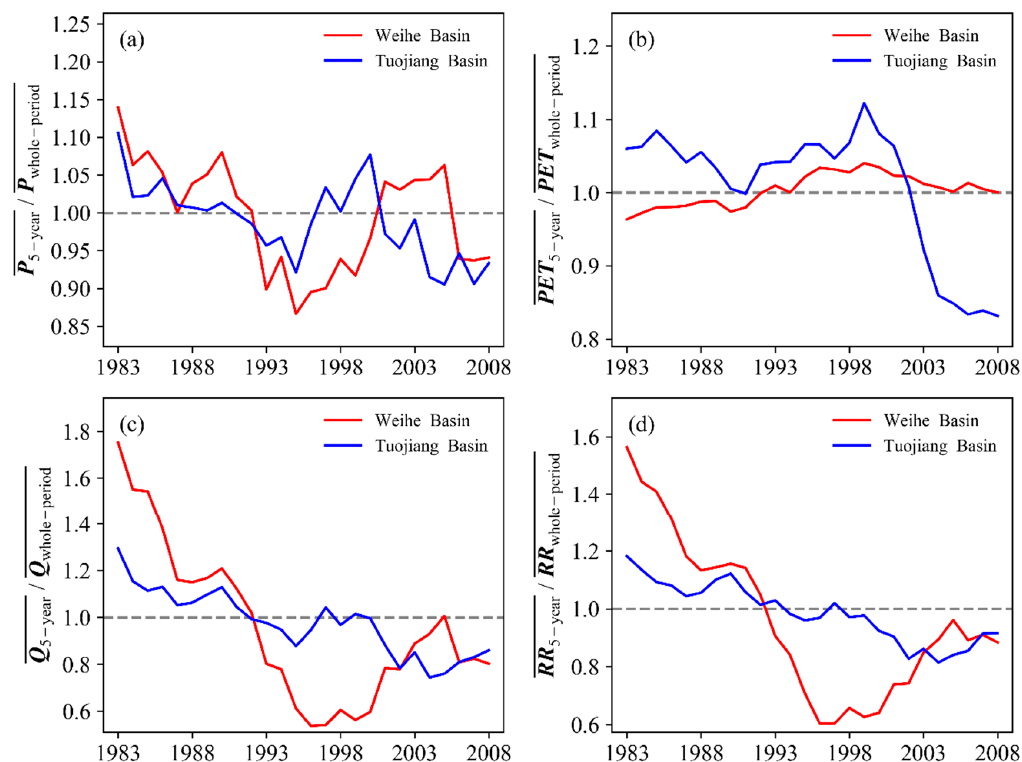
Figure 3. Relative long-term hydro-meteorological variability of ( a ) precipitation ( P ), ( b ) potential evapotranspiration ( PET ), ( c ) runoff ( Q ), and ( d ) runoff ratio ( RR ) over Weihe Basin and Tuojiang Basin.